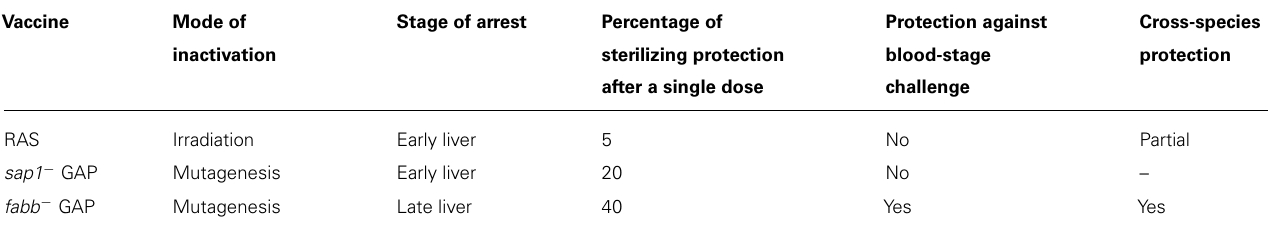
Table 1 | Comparison between early- and late-liver stage arresting whole-sporozoite vaccines.